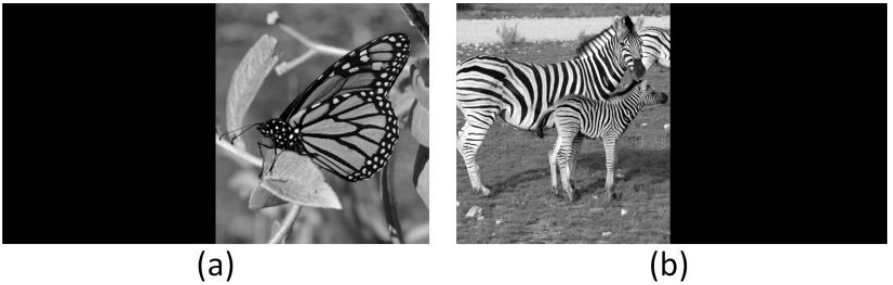
Figure 2. ( a ) ‘ butterfly ’ and ( b ) ‘ zebra ’ are used to represent 2 different depth layers of the 3D scene . Figure 2. ( a ) ‘butterfly’ and ( b ) ‘zebra’ are used to represent 2 different depth layers of the 3D